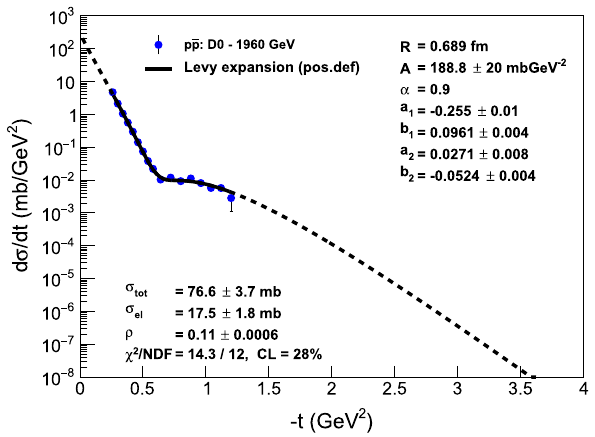
Fig. 28 Second-order Lévy expansion fits of the differential cross- section data on p ¯ p elastic scattering at fixed α = 0 . 9 and R = 0 . 689